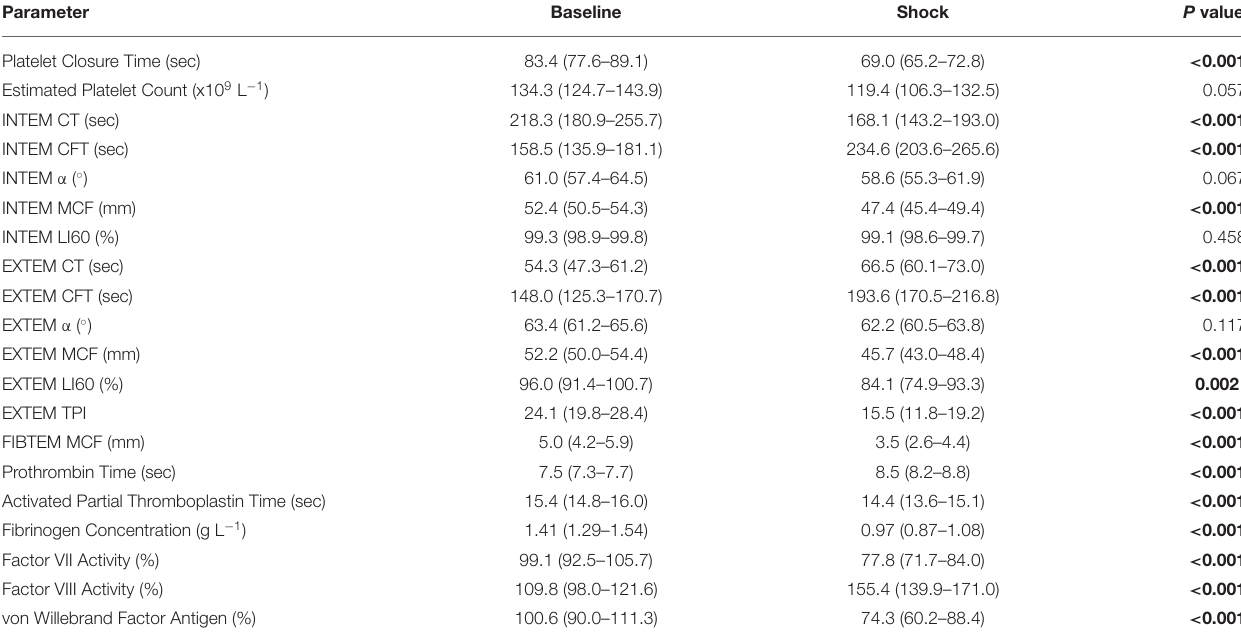
TABLE 5 | Platelet closure time and count, rotational thromboelastometry, and plasma coagulation assay parameters (mean, 95% confidence interval) in dogs ( n = 24) with hemorrhagic